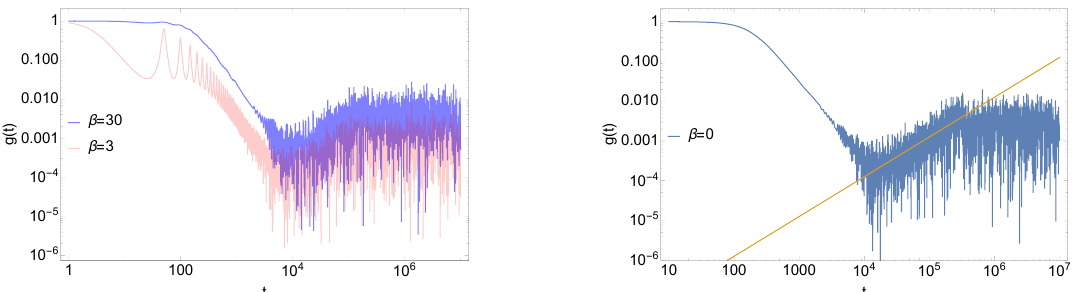
Figure 6. Left: β dependence of SFF for BTZ black hole with z 0 = 30 , n cut = 200 and J cut = 200 . Right: ramp part of SFF for BTZ black hole ( z against the yellow line whose equation is log g ( t ) = log t + constant.